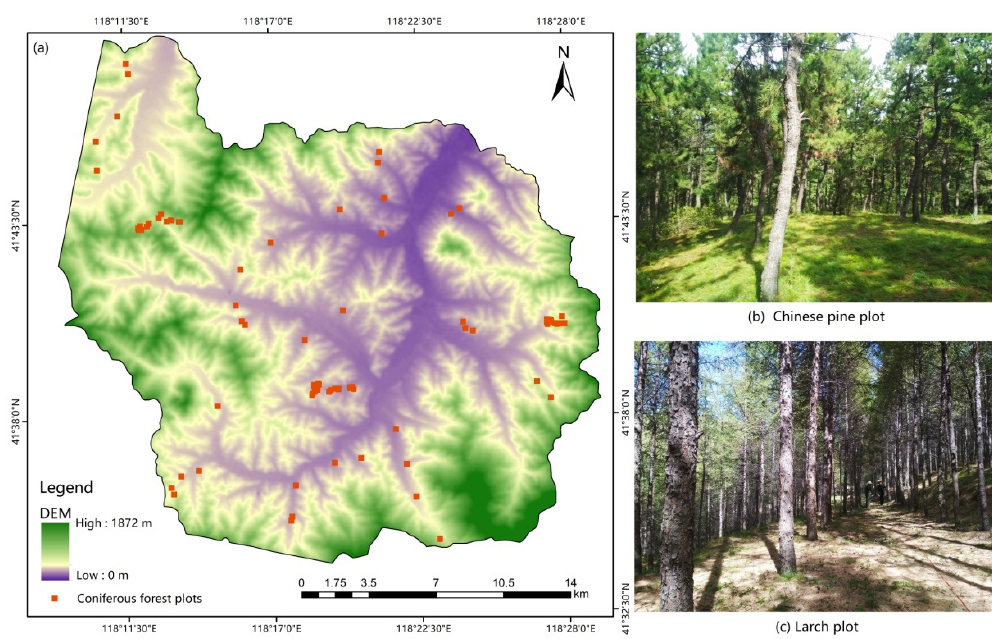
Table 1. Statistical summary of the growing stem volume (m 3 /ha) at the field plots.